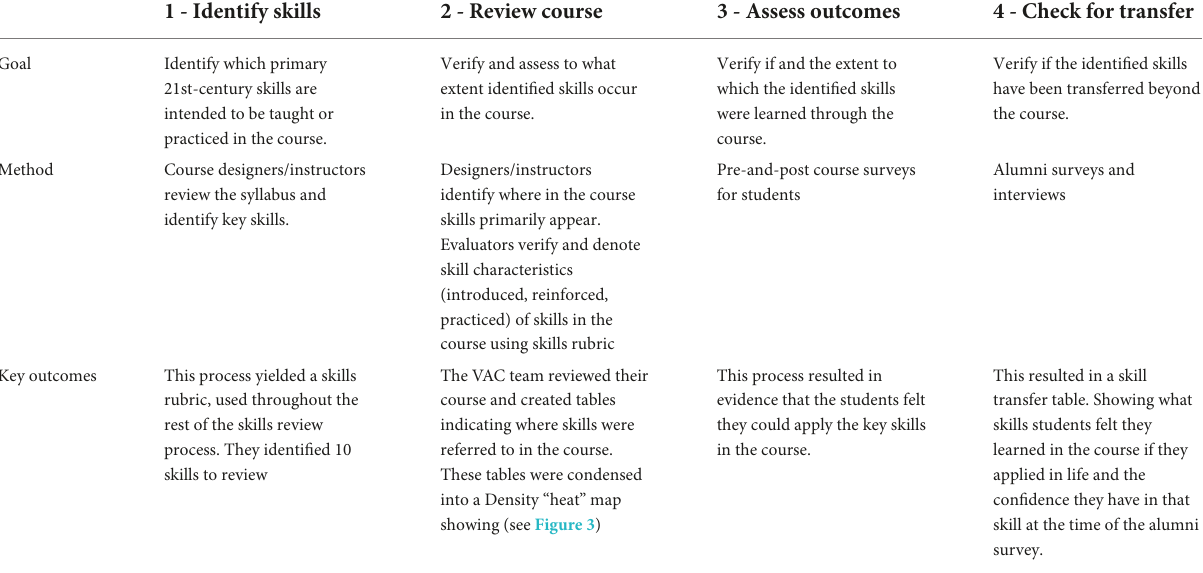
TABLE 3 The frequency of skills addressed in the course and how the skill was addressed (reinforced or practiced). 1 - Identify skills 2 - Review course 3 - Assess outcomes 4 - Check for